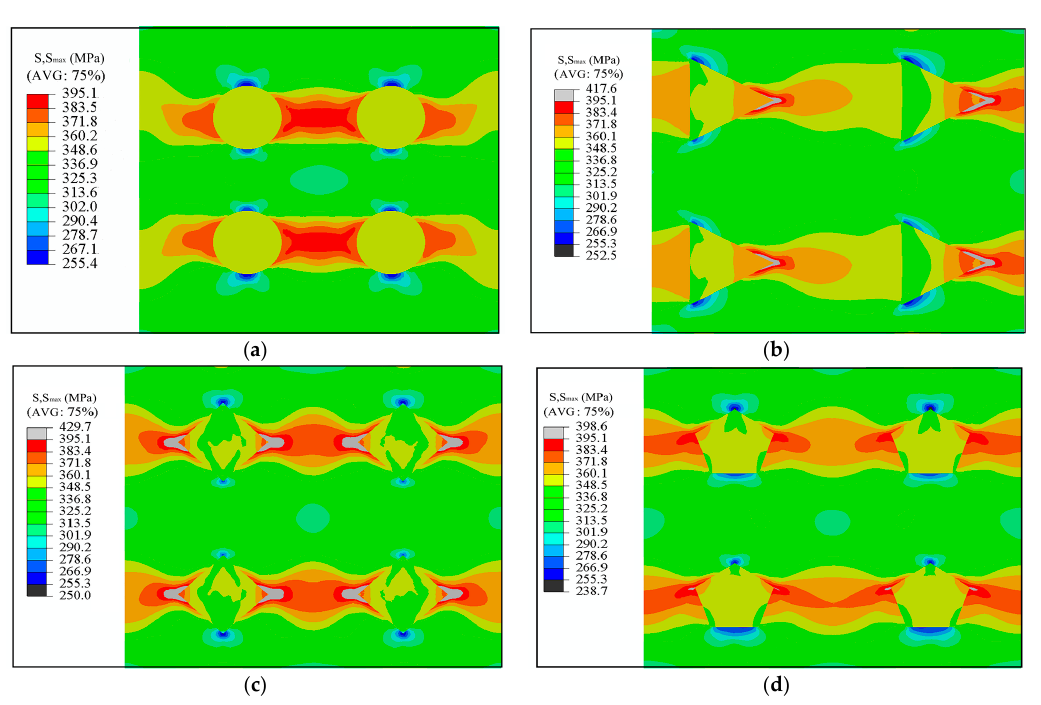
Figure 6. S max distribution of the composite models with different SiCp shapes: ( a ) round particle doping; ( b ) equilateral triangle particle doping; ( c ) square particle doping; and ( d ) regular pentagon particle doping.